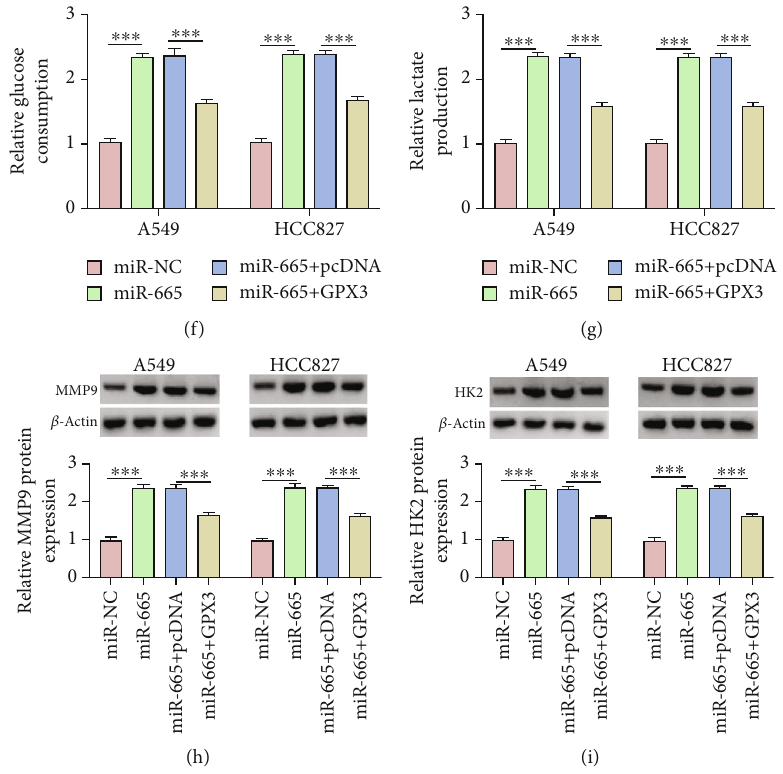
Figure 6: GPX3 regulates the proliferation, migration, and invasion by targeting miR-665 in NSCLC cells. (a, b) The protein level of GPX3 was determined by Western blot. (c) Colony formation assay was used to assess proliferation of transfected A549 and HCC827 cells. (d, e) Transwell assay was used to assess cell migration and invasion. (f, g) Glucose consumption and lactate production were measured to assess glycolysis metabolism using commercial kits. (h, i) The protein level of MMP9 and HK2 was detected by Western blot. ∗∗∗ P < 0 : 001